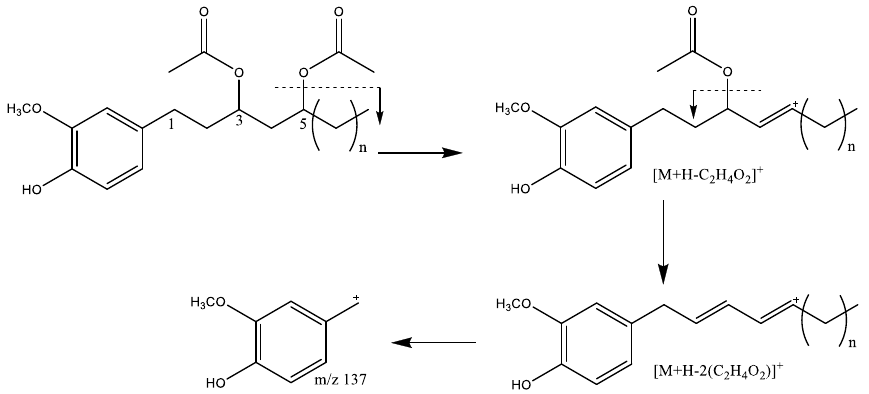
Figure 10. Fragmentation pathway for diacetoxy-gingerdiol compounds 8 ( n = 4), 18 ( n = 6), 26 ( n = 8), 32 ( n = 10).